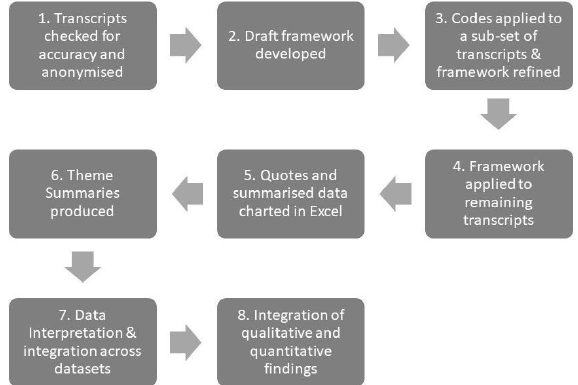
Figure 2. Qualitative analysis process using the Framework Method.